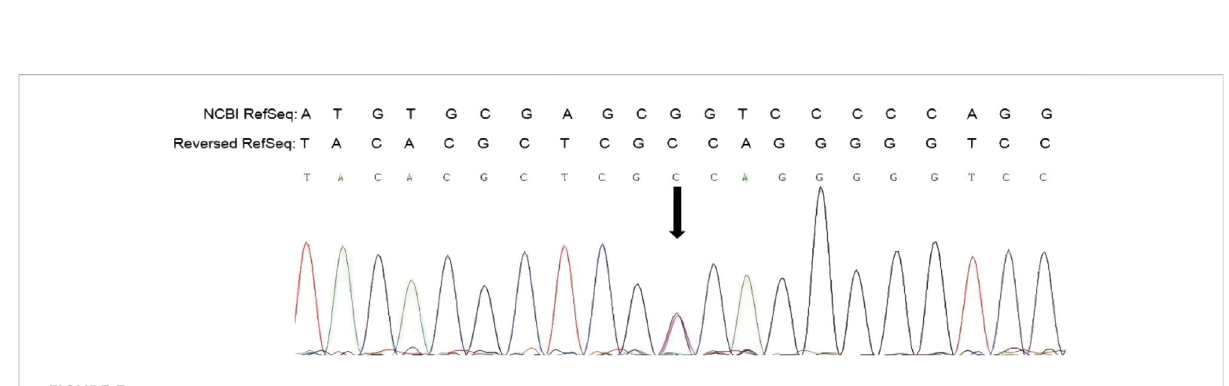
FIGURE 3 First-generation DNA sequencing of male partner ’ s